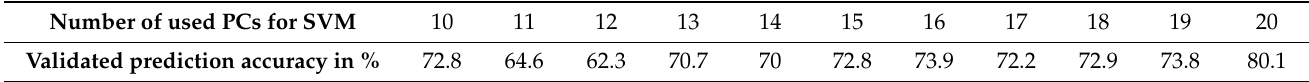
Table 3. Number of used PCs for SVM models and validated prediction accuracy for new data collected from samples on stainless-steel slide.